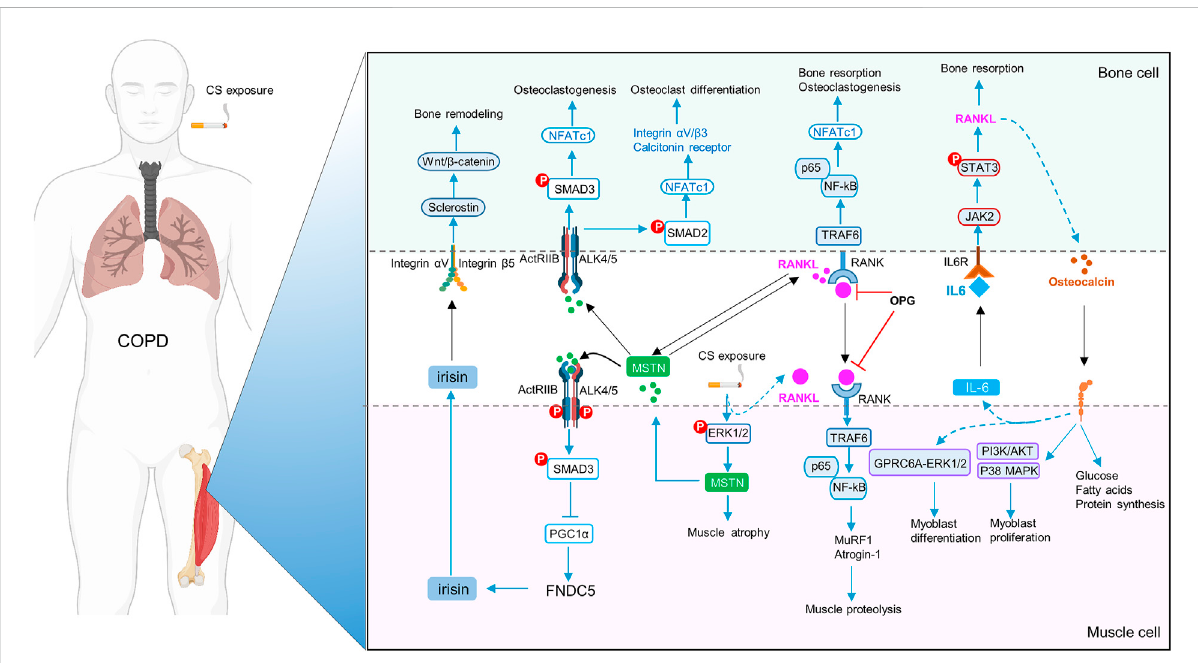
FIGURE 1 Schematic diagram of muscle-bone crosstalk in COPD. FNDC5/irisin is decreased, whereas IL-6, myostatin (MSTN) and RANKL/RANK are increased in skeletal muscles in COPD. Cigarette smoke extract (CSE), via enhanced p-ERK1/2, increases expression of MSTN, which further inhibits FNDC5/irisin expression through p-Smad3/PGC-1 α pathway. MSTN also promotes osteoclastogenesis and osteoclast differentiation by NFATc1. Irisin upregulates sclerostin through integrin α V/ β 5 in the osteocytes, thereby inducing bone remodeling. RANKL activates the homologous receptor RANK on the surface of osteoclasts and osteoclast precursors, and activated RANK causes the recruitment of the adapter protein TRAF6, leadingtoNF-kBactivation,therebytriggeringthetranscriptionofosteoclastogenicgenesandboneresorption.Moreover,RANKLsignalingcanalso lead to muscle dysfunction by upregulation of MSTN and activation of the ubiquitin-proteasome system (MuRF1 and Atrogin1) and the NF- κ b pathway.OPG,thedecoyreceptorofRANKL,preventsosteoclastformationandboneloss.Duringexercise,muscle-derivedIL-6(mIL-6)actsonthe IL-6 receptor of osteoblasts and increases the production of RANKL through STAT3 signaling pathway, subsequently promoting osteoclast differentiation and production of bioactive osteocalcin in osteoclasts. In turn, osteocalcin also enhances the production of mIL-6 during exercise, and promotes myoblast differentiation and